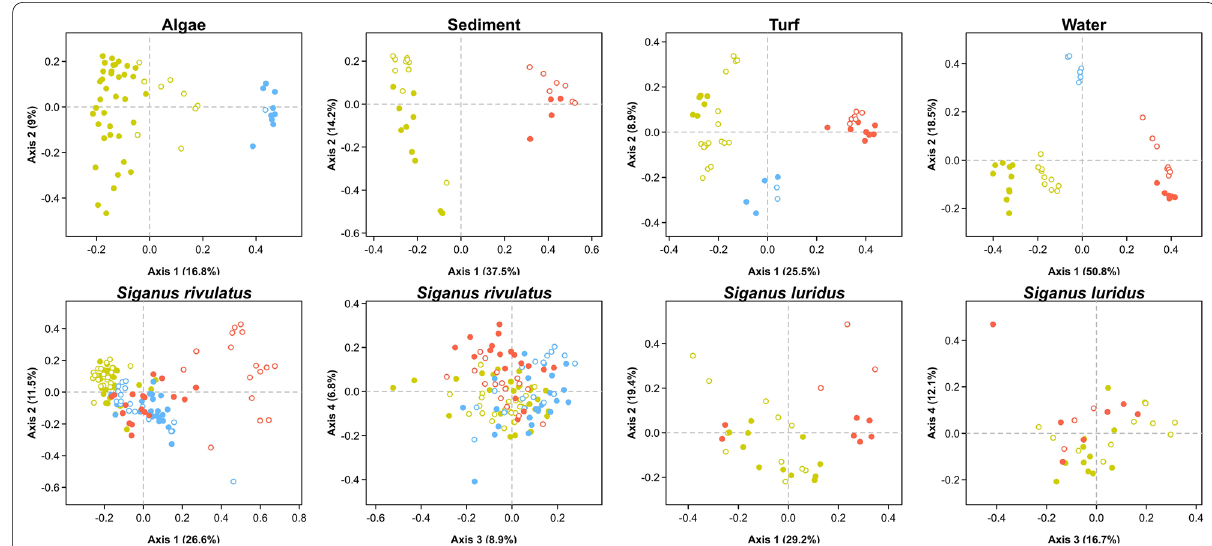
Fig. 2 Regional and seasonal differences in the structure of environmental and fish gut microbiomes. Principal Coordinates Analyses (PCoA) were performed on abundance‑weighted taxonomic dissimilarity computed on microbial ASVs (partitioning of taxonomic entropy expressed as Hill numbers). For each ecosystem compartment, red, blue and green dots correspond to samples from Red Sea, Levantine Sea and Northern Crete, respectively, with filled and empty dots correspond to spring and autumn, respectively. For gut microbiomes of both Siganidae species (bottom row), the first two pairs of PCoA axes are represented (PC1‑PC2 and